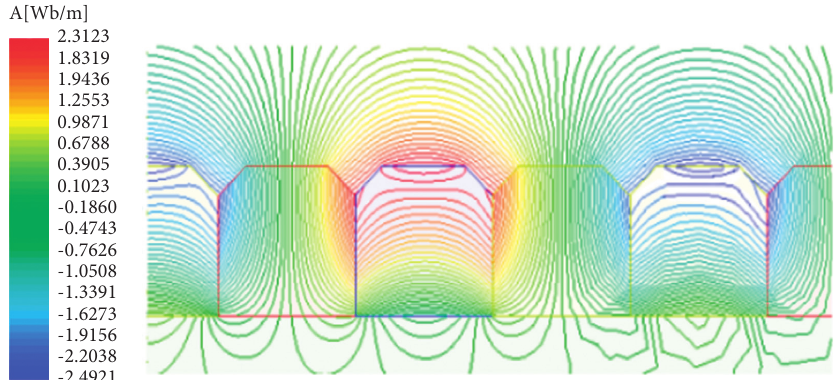
Figure 14: Cloud diagram of finite element analysis of magnetic line of the